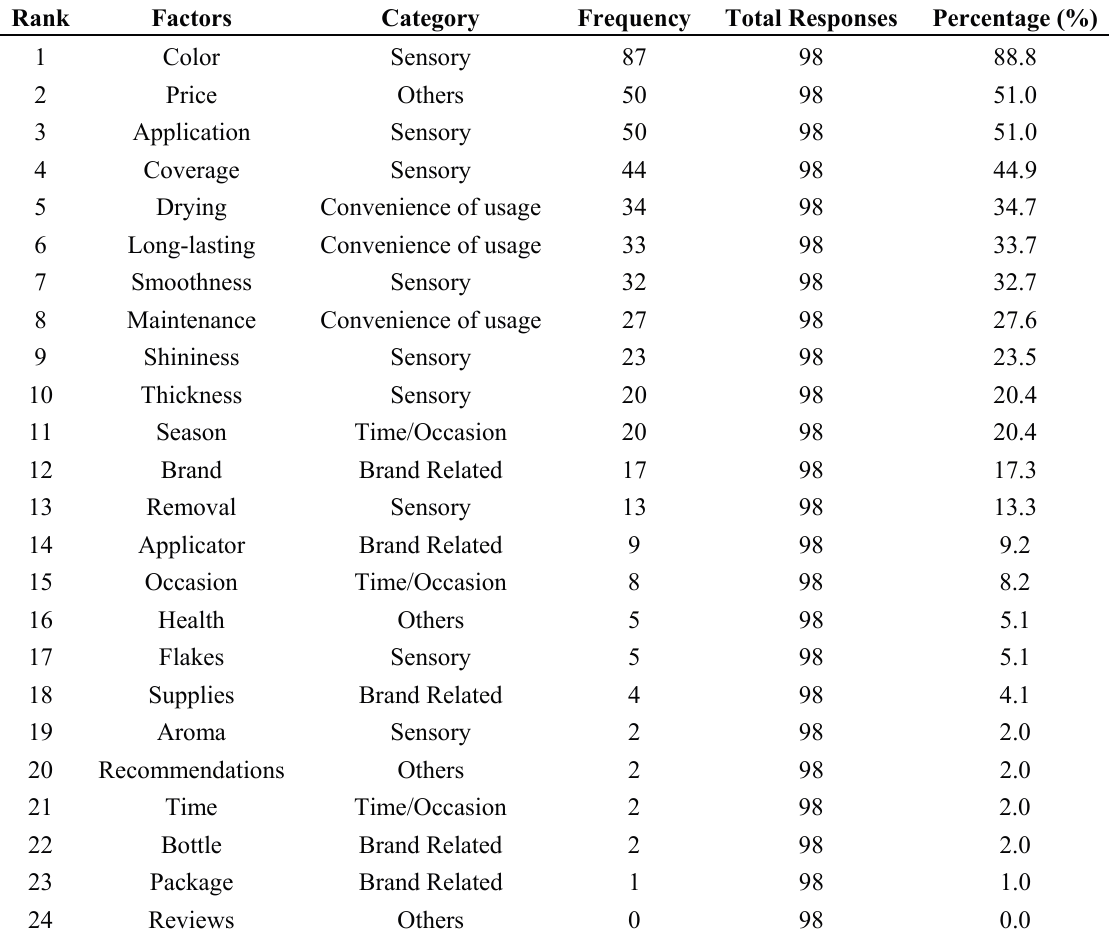
Table 3. Frequency table for factors that may affect female consumers’ decision on purchasing nail